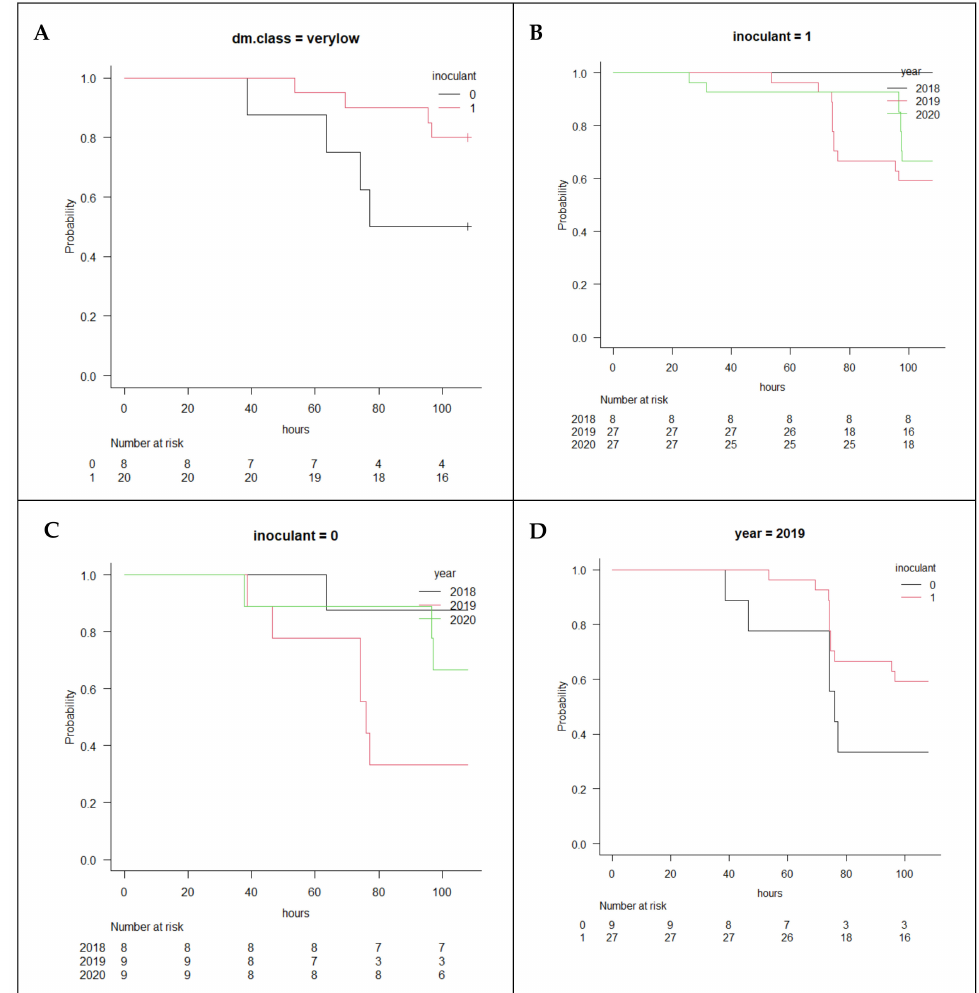
Figure 1. ( A ), the Kaplan Meier curve for the probability of aerobic instability onset of maize silage exposed to air right-censored at 108 h, for the use of Lactobacillus buchneri (inoculant = 1, n = 20) or pure water (inoculant = 0, n = 8) for maize harvested with dry matter ≤ 300 g/kg ( p = 0.079). ( B ), the Kaplan Meier curve for the probability of aerobic instability onset of maize silage exposed to air right-censored at 108 h, using Lactobacillus buchneri (inoculant = 1) for maize harvested within different years (2018, 2019, and 2020, p = 0.05). ( C ), the Kaplan Meier curve for the probability of aerobic instability onset of maize silage exposed to air right-censored at 108 h, without the use of Lactobacillus buchneri (inoculant = 0) for maize harvested within different years (2018, 2019, and 2020, p = 0.10). ( D ), the Kaplan Meier curve for the probability of aerobic instability onset of maize silage exposed to air right-censored at 108 h, for the use of Lactobacillus buchneri (inoculant = 1) for maize harvested in 2019 with or without the use of inoculants ( p =